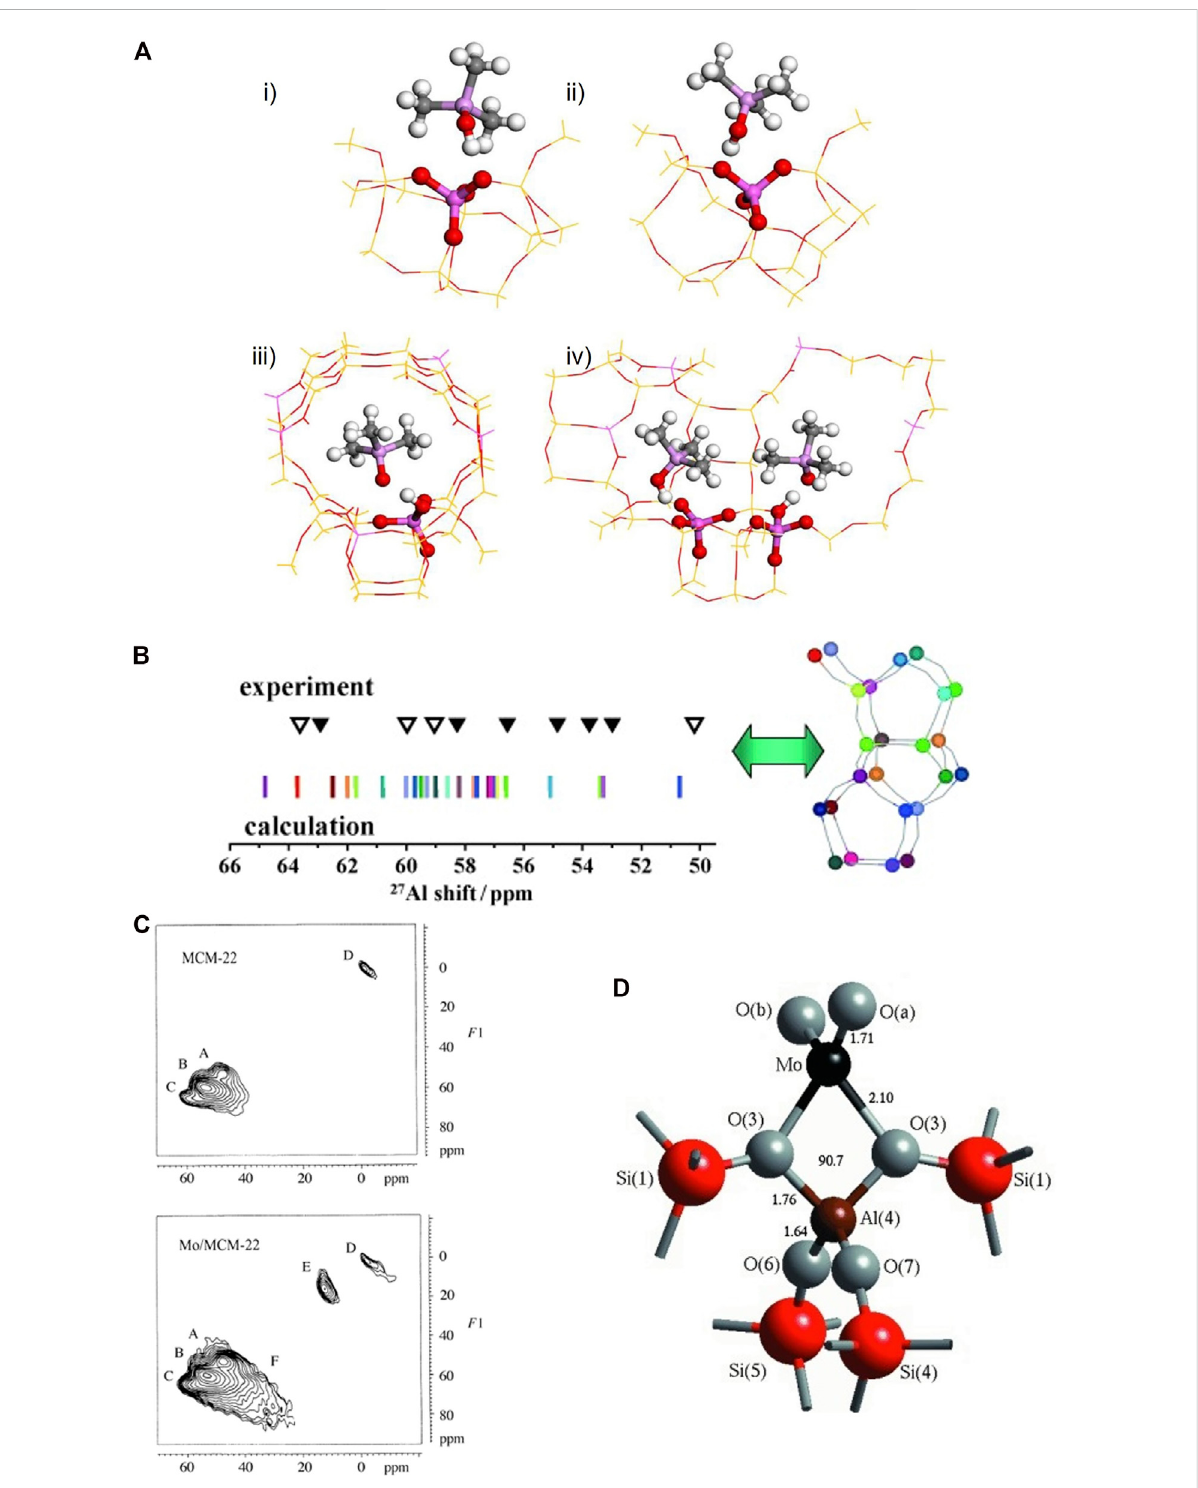
FIGURE 3 (A) Models of TMPO adsorbed onto different T sites: (i) T1, (ii) T9, (iii) 6MR-2AL (T6, T6), (iv) 5MR2-2AL (T1,T5). Al – pink, O – red, P – purple, C – black, H – white. Reprinted with permission from ref (Zhao etal., 2017) . Copyright 2017 American Chemical Society ; (B) Comparison of calculated and experimental resonances corresponding to Al in different crystallographic sites. Reprinted with permission from ref (Sklenak et al., 2007) © 2007Wiley-VCHVerlagGmbHandCo.KGaA,Weinheim ; (C) 2DAlMqMASSpectraofMo/MCM-22showthreetetrahedralframeworkalumina (A,B,C) and one octahedral alumna (D) along with Mo loading signals (E,F); (D) Coordination of Mo to the framework of ZSM-5. Reprinted with permission from ref (Ma et al., 2002) © 2002 Wiley-VCH Verlag GmbH and Co. KGaA,